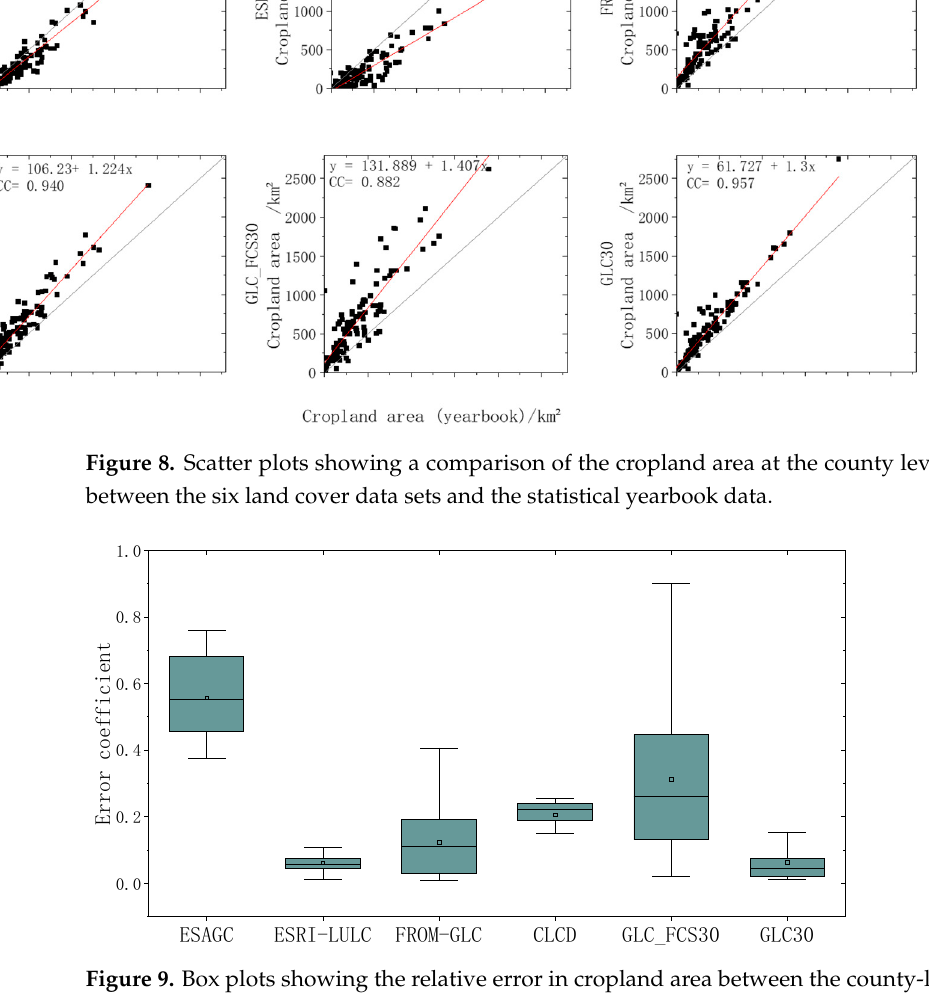
Figure 9. Box plots showing the relative error in cropland area between the county-level cropland data in the different land cover products and the yearbook data for Guangxi.